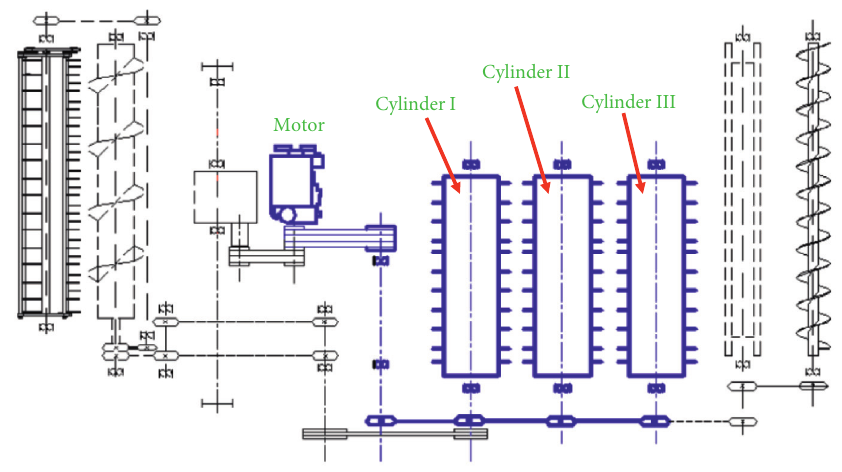
Figure 1: Multicylinder power transmission route belonging to combine harvester.